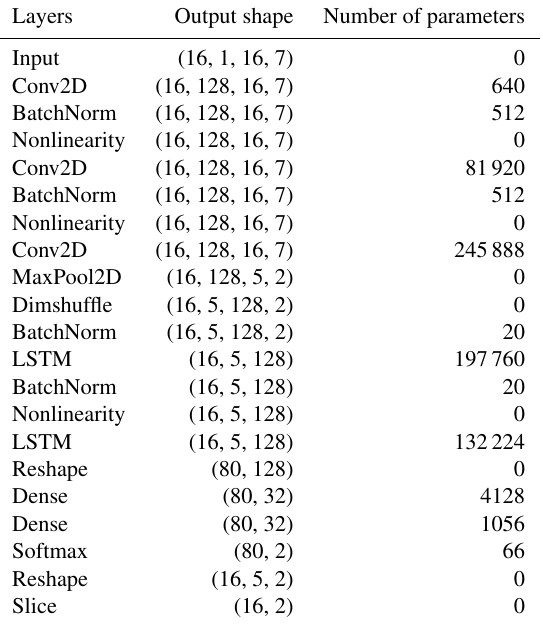
Table 8. Layers, output shapes, and number of parameters for the CNN-LSTM model.